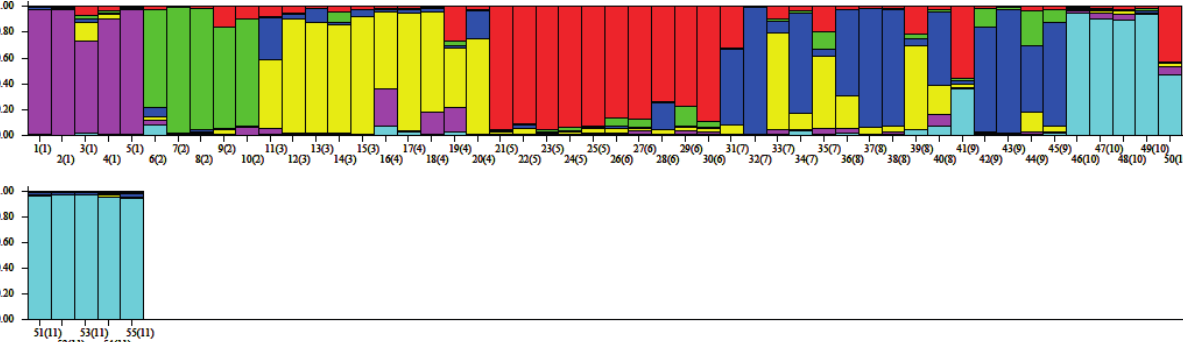
Figure 3. STRUCTURE plot of Alcea species based on SRAP